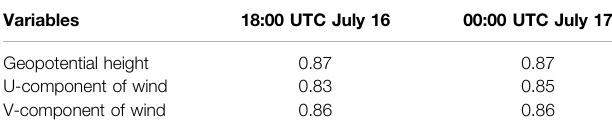
TABLE 1 | List of the correlation coef fi cients of the 700 hPa geopotential height, 700-hPa U-component ofwind, and 700-hPa V-component ofwind between the control simulation (CTL) run (Domain 02) data and FNL